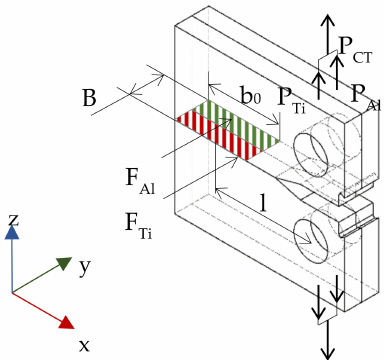
Figure 10. Scheme of the model reference